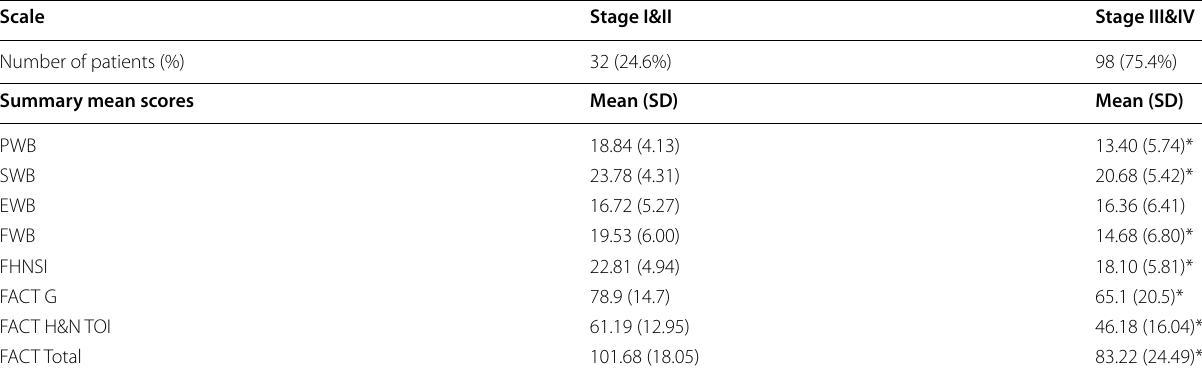
Table 4 Cross sectional validity results